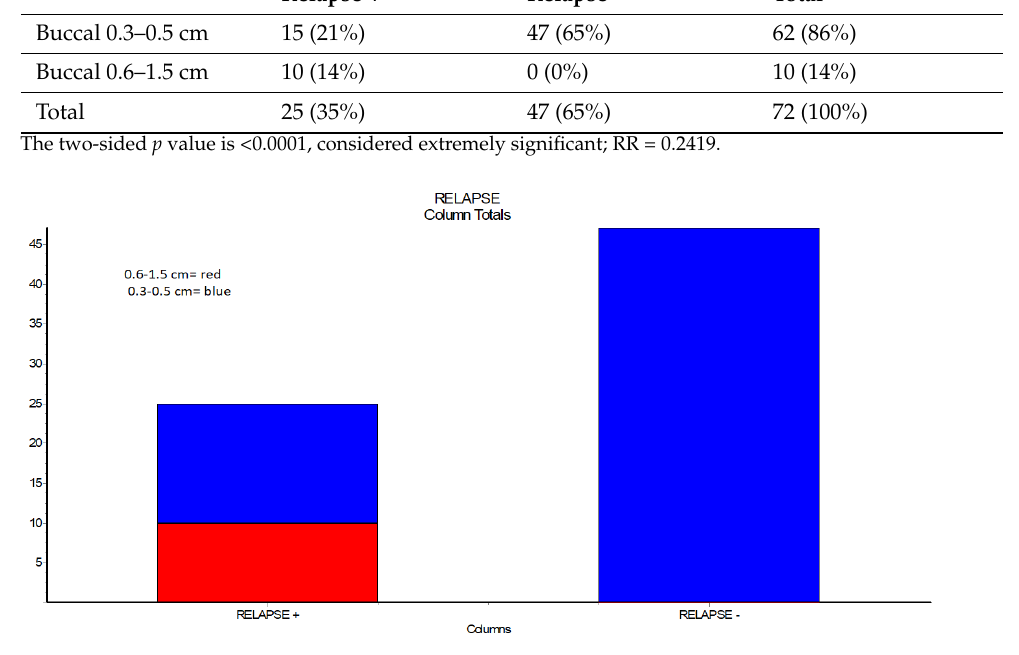
Figure 1. Relapse in case of surgical closure with Bichat fat pad flap and case of closure with Buccal advancement flap.